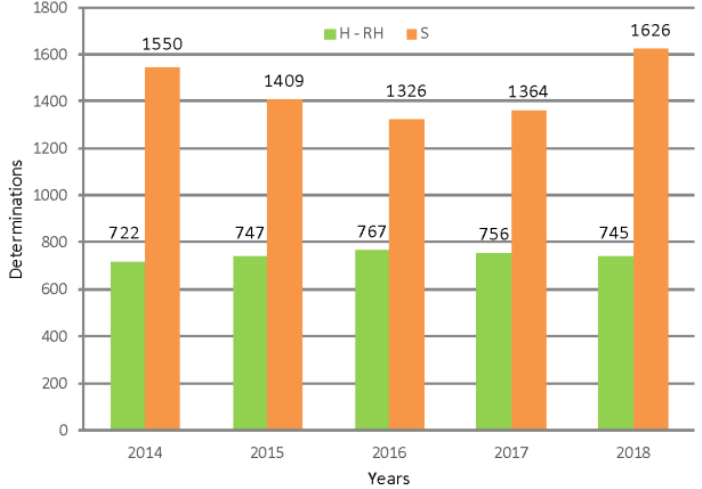
Figure 2. Number of analytical determinations performed in schools (S) and hospitals/retirement homes (H-RH).